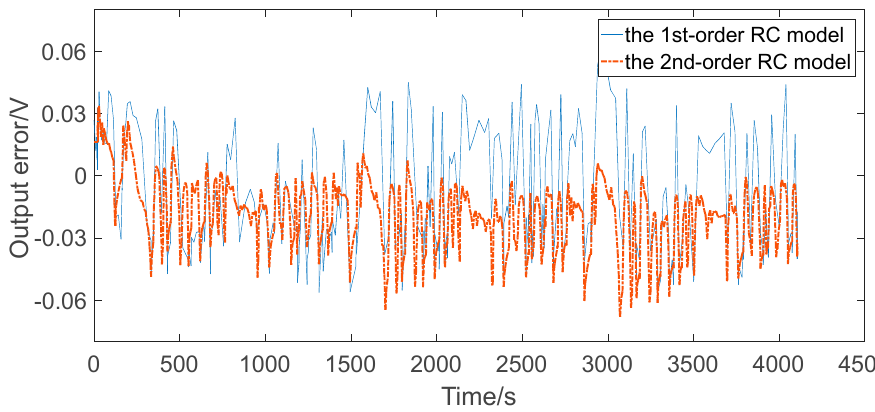
Figure 16. Output errors of the first-order and second-order RC model for UDDS cycle.